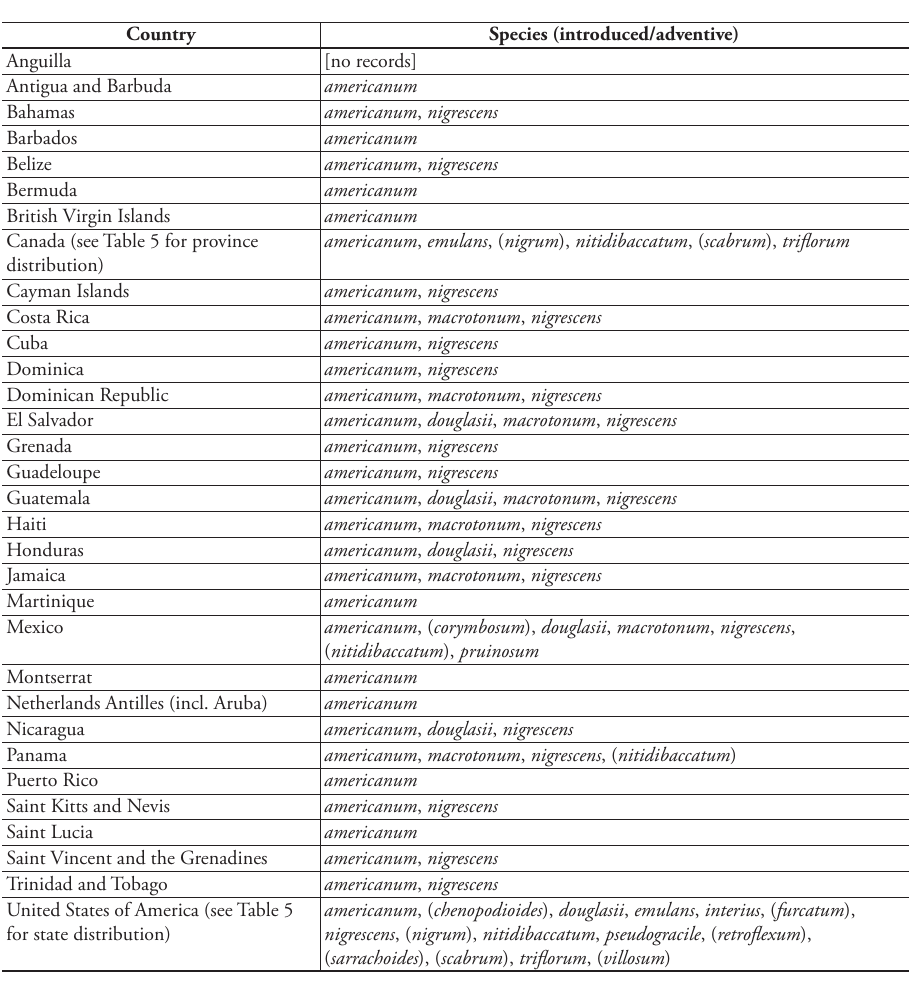
Table 4. Morelloid species distribution by country for the Caribbean, North and Central America; intro- duced/adventive species are in brackets